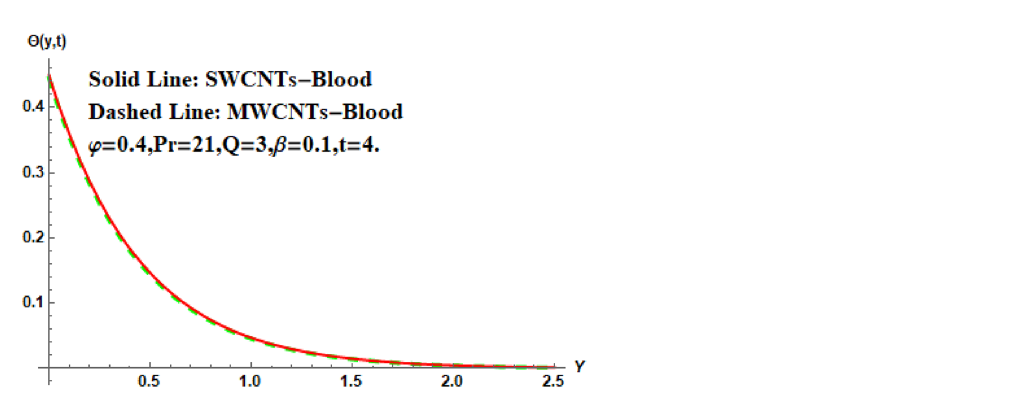
Figure 13. Analysis of SWCNTs and MWCNTs on �( Y , t )